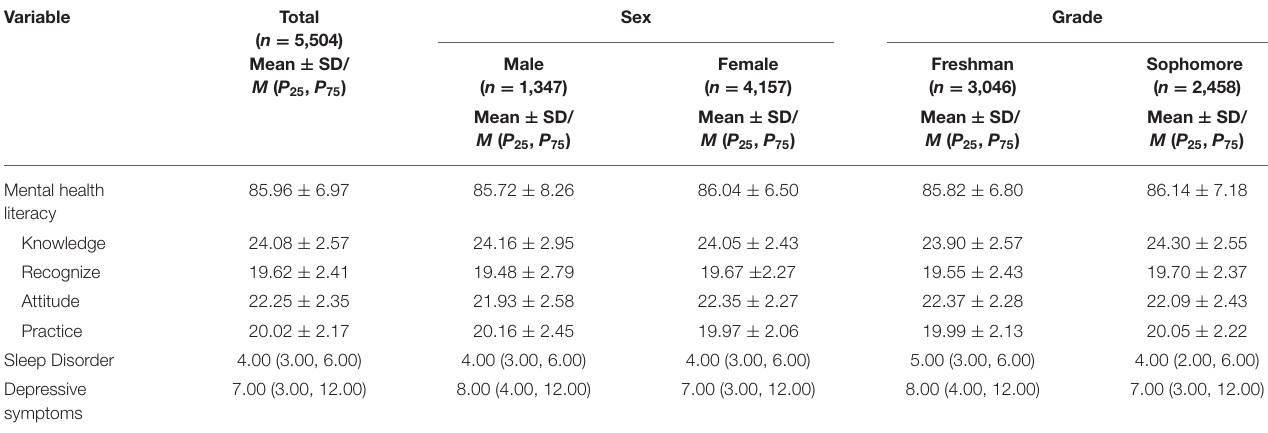
TABLE 2 | Descriptive statistics for